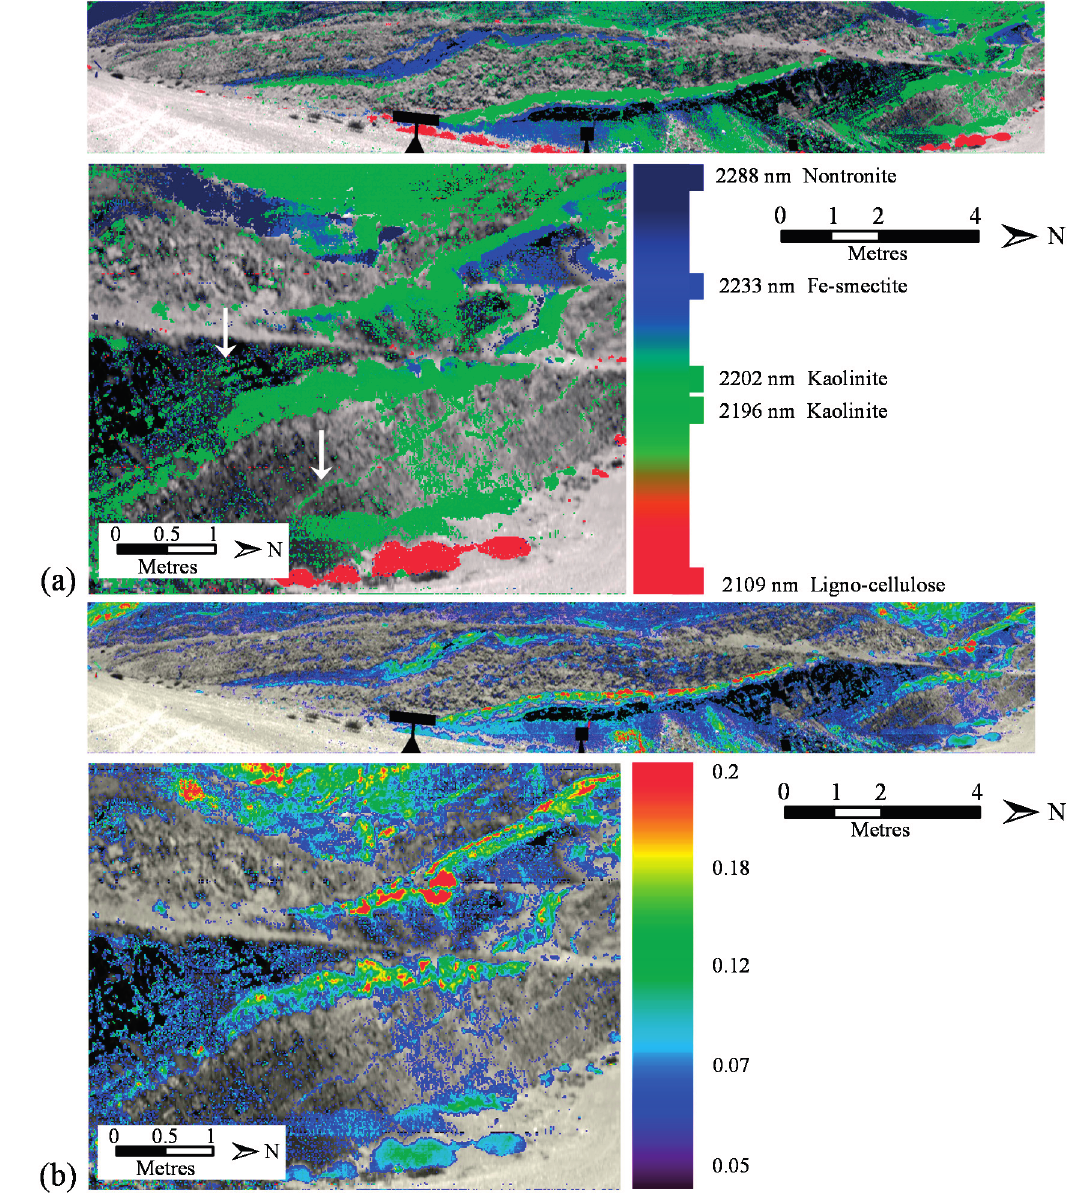
Figure 8. Maps of clay absorption features showing the location of clay layers over the entire mine face. Data are for the deepest absorption feature in each pixel spectrum within the depth threshold (0.95), pixels which do not have absorption features within this threshold are shown as grey-scale values of reflectance at 2029 nm. ( a ) Wavelength position; ( b ) Depth. Location of clay layers mapped by AFE but not observed in the field are indicated by arrows in